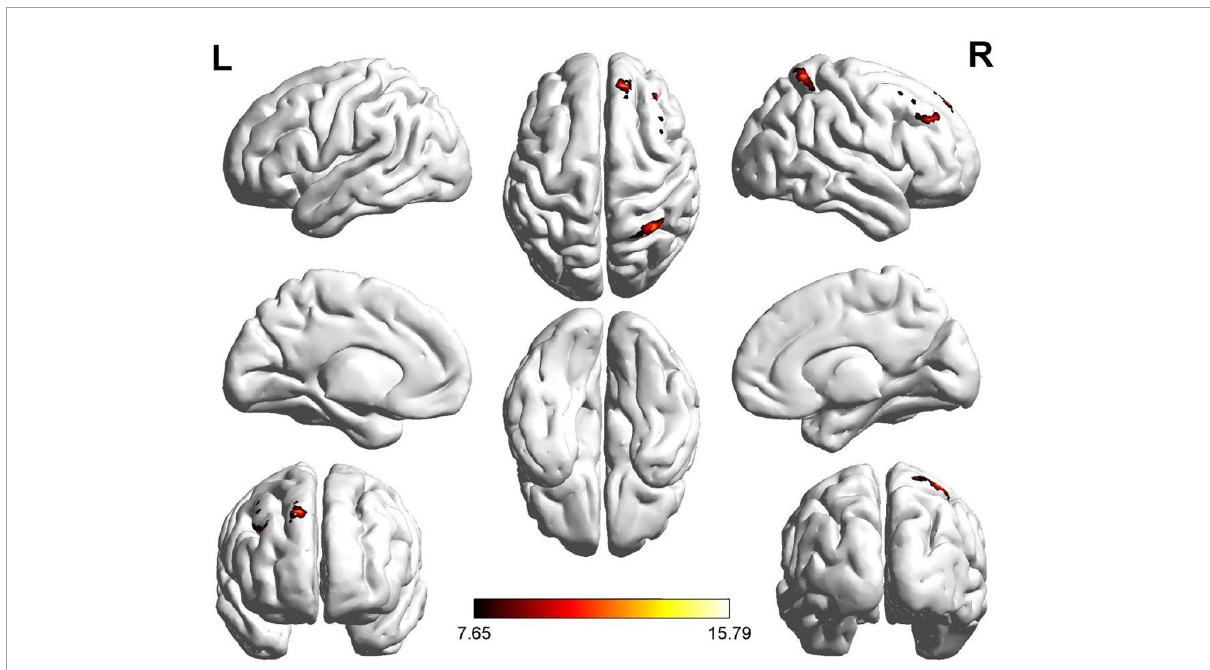
FIGURE5 Significant FC patterns were observed between the right dorsolateral SFG and the right middle frontal gyrus (MFG), right superior parietal gyrus (SPG), and right dorsolateral SFG in the recent-onset tinnitus (ROT) and persistent tinnitus (PT) groups, compared to the healthy control group.